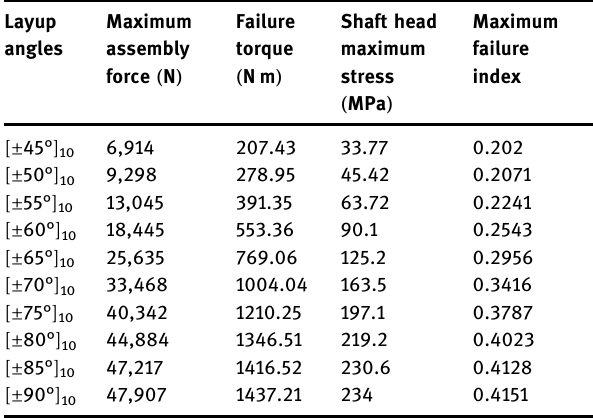
Table 4: Evaluation index of interference fi t joints at di ff erent